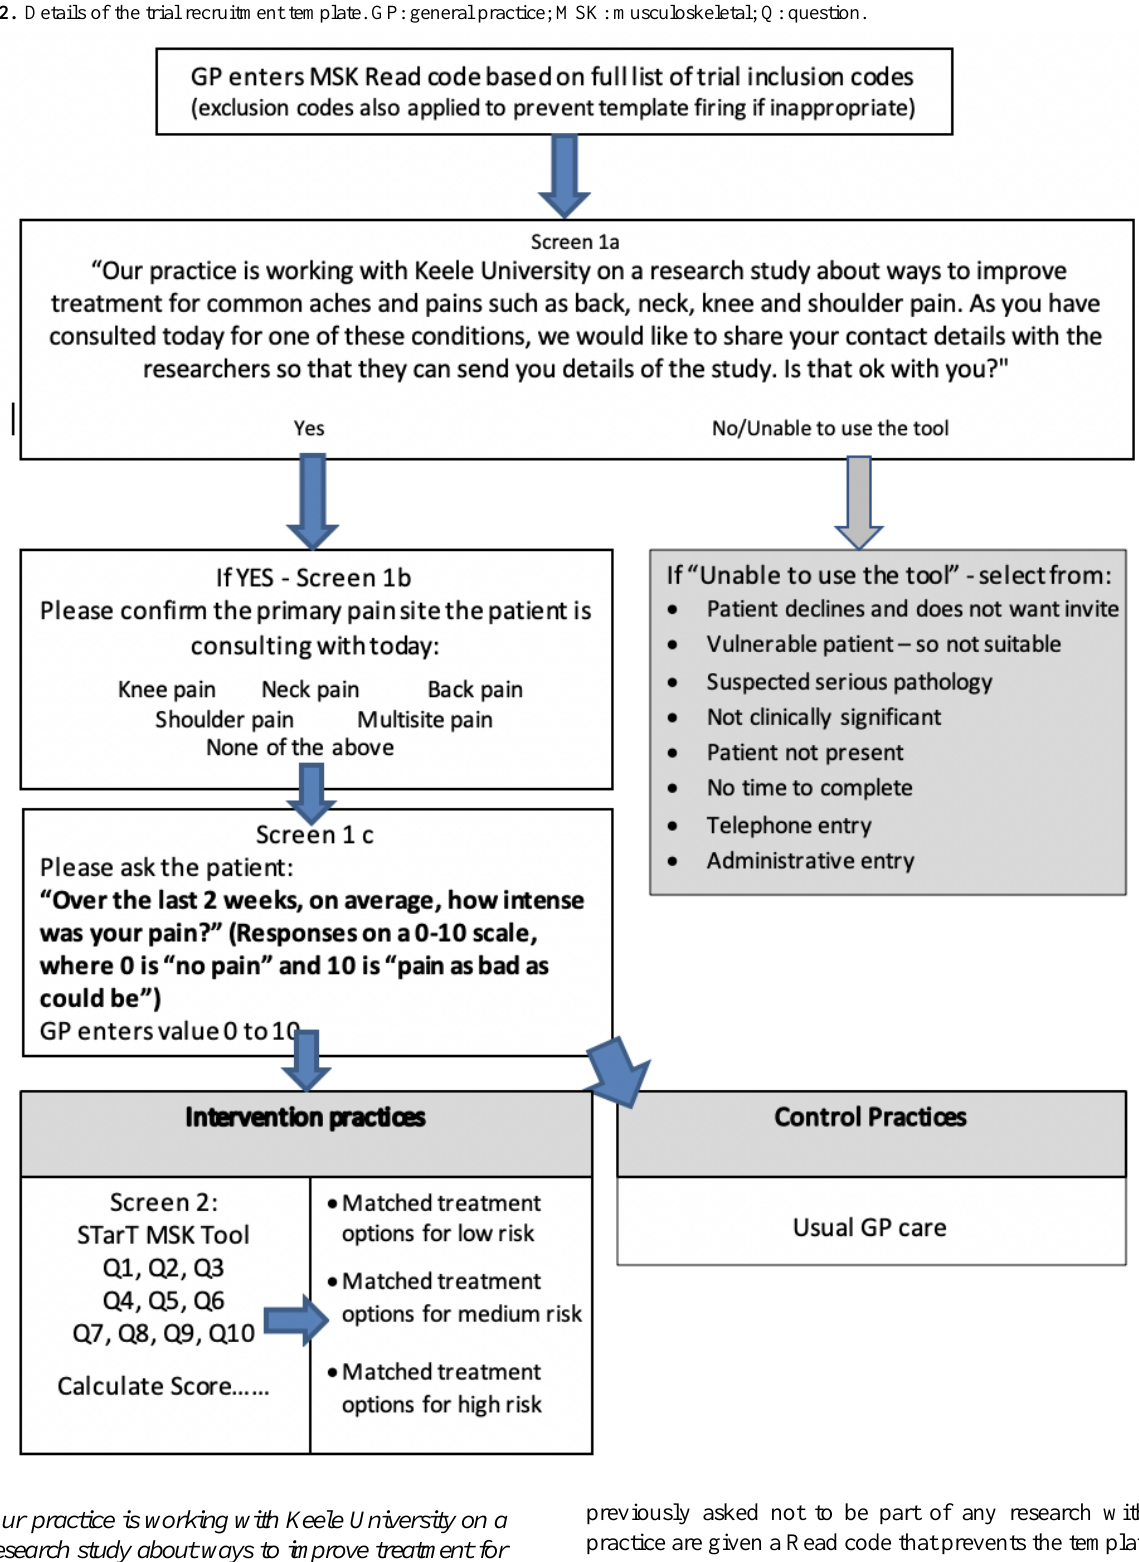
Figure 2. Details of the trial recruitment template. GP: general practice; MSK: musculoskeletal; Q: